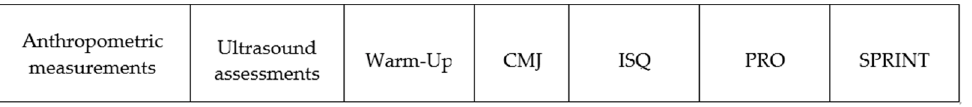
Table 1. Anthropometric and performance parameters. ISQ = isometric squat; pRFD20 = peak rate of force development; PRO = pro-agility test.